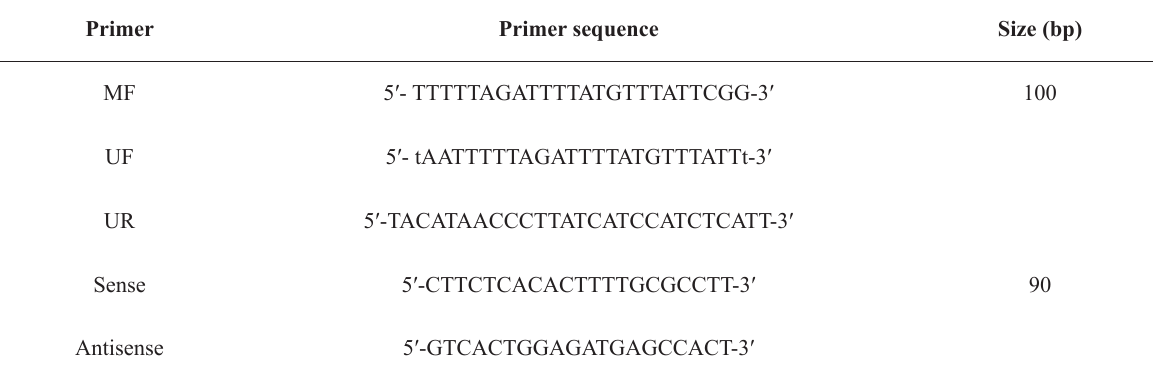
Primers of TBX22 used for MSP and qPCR.